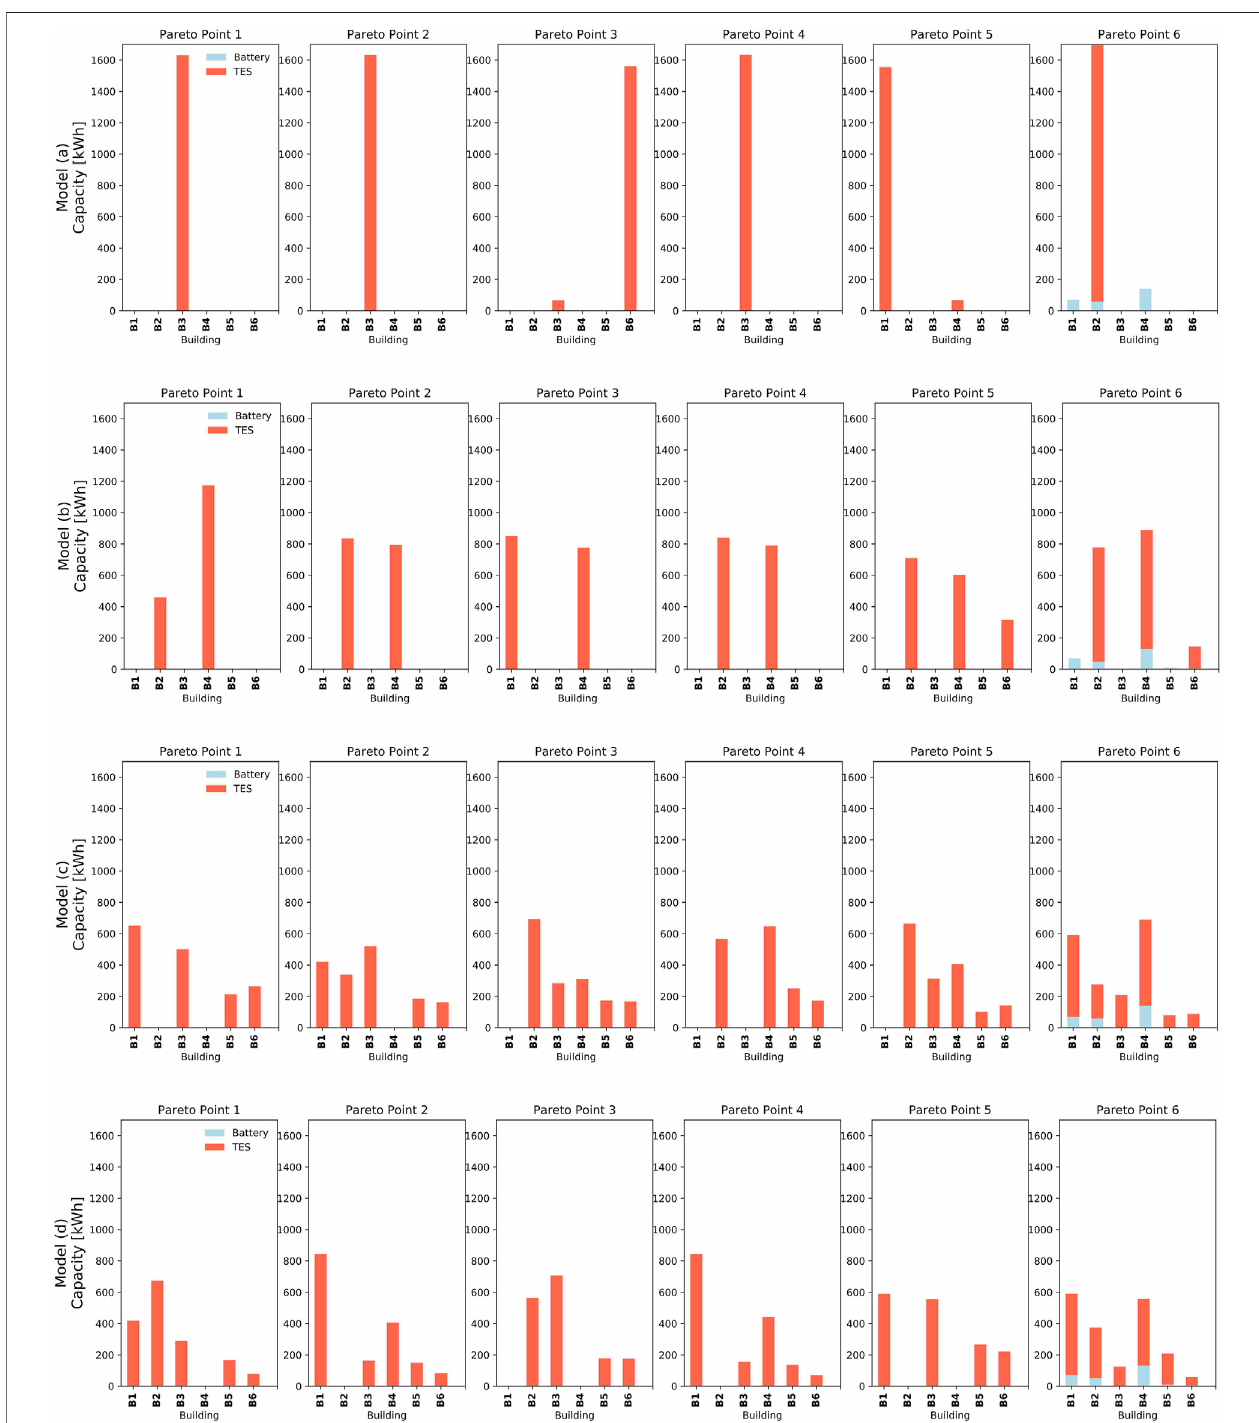
FIGURE 13 | Design capacities of storage technologies (TES and Battery) from the model (A) - (D) .